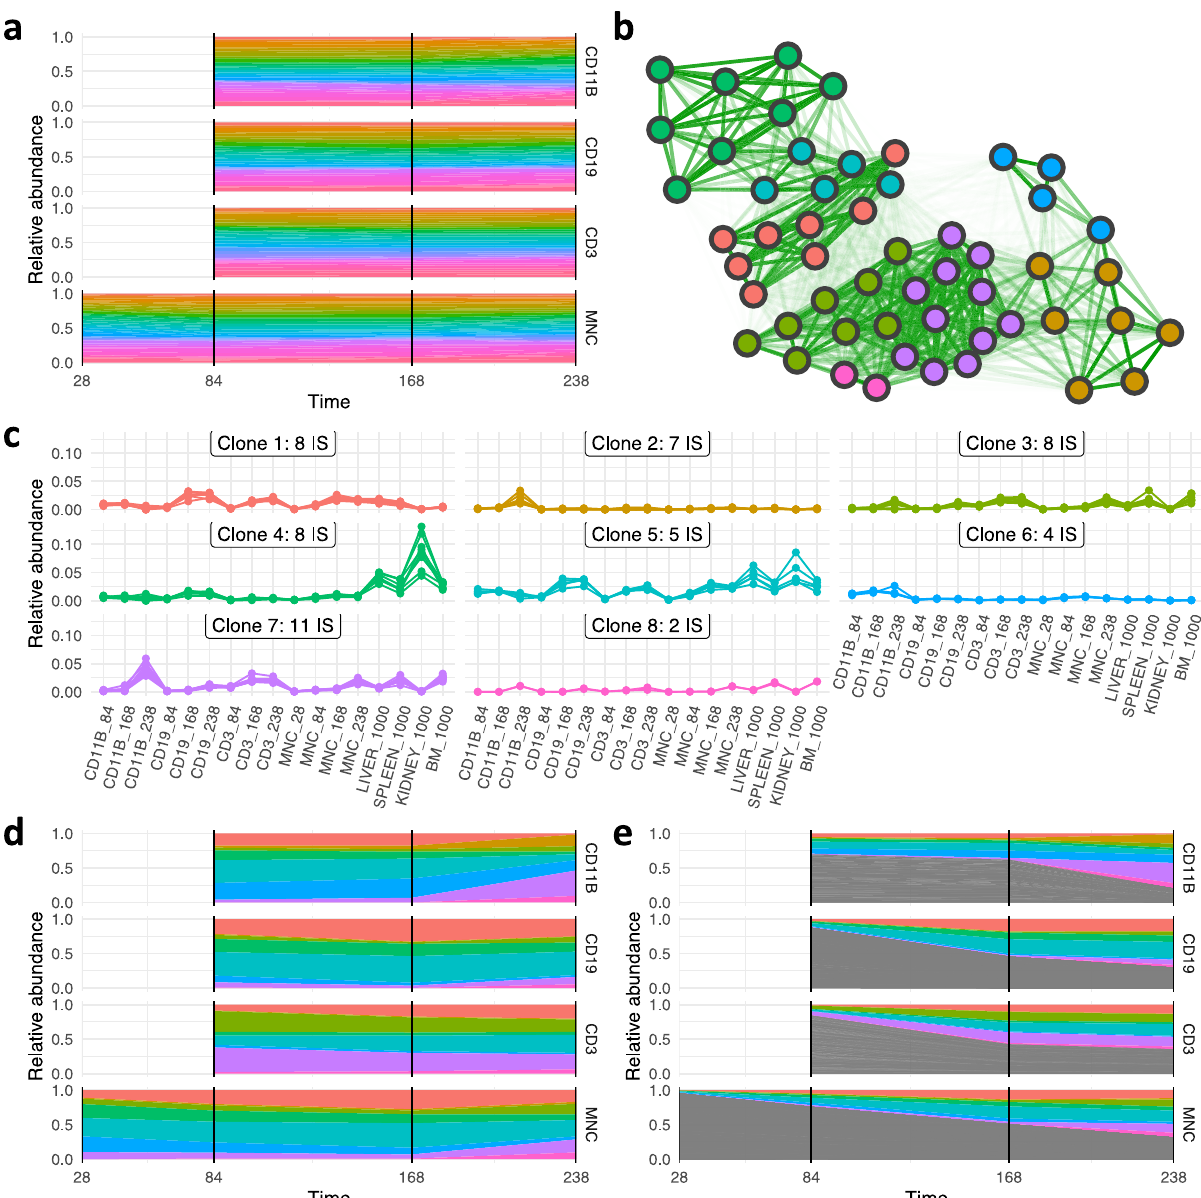
Fig. 6 Experimental data and clonal reconstruction for mouse pool E4C. a Relative abundances of IS as a function of time for subsets of CD11b, CD19, CD3, and mononuclear cells, for which multiple measurements are available. b The network map depicts the similarity between each pair of IS (indicated by edge brightness) superimposed by the optimal clustering obtained from the reconstruction pipeline (indicated by color of the nodes). c Time series of all IS assigned to the same clusters for all available compartments and time points (preserving the color scheme). d Corrected clonal time series for the eight identi fi ed clones. e Corrected clonal time series together with the IS that did not pass the initial fi ltering step (indicated in